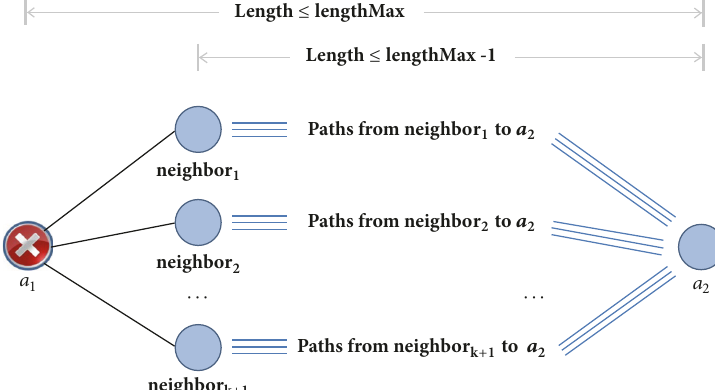
Figure 1: Recursive finding of the set of paths between vertices 𝑎 1 and 𝑎 2